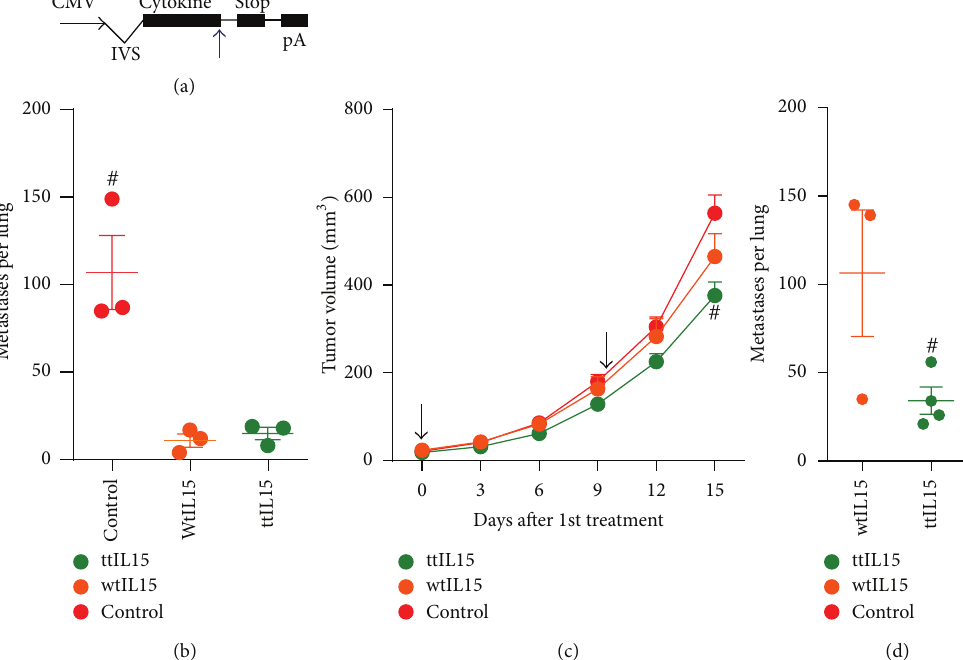
Figure 3: Tumor-targeting-mediated improvement of IL15-induced antitumor efficacy depends on the tumor histotype. (a) Diagrammatic representation of the IL15 plasmid with the IL15-coding region in the “Cytokine” region. The blue arrows represent the VNTANST-coding sequence insertion site in the plasmid DNA. CMV: cytomegalovirus promoter; IVS: intron; pA: bovine growth hormone polyadenylation signal; STOP: stop codon. (b) Equivalent inhibition of K7M3 lung metastases from wtIL15 and ttIL15 pDNA treatments (treatments on days 0 and 7). Inhibition of primary tumor growth (c) and metastatic lung tumor development (d) by ttIL15 pDNA compared to wtIL15 pDNA. Black arrows represent treatments. # represents 𝑃 < 0.05 compared to all other groups.